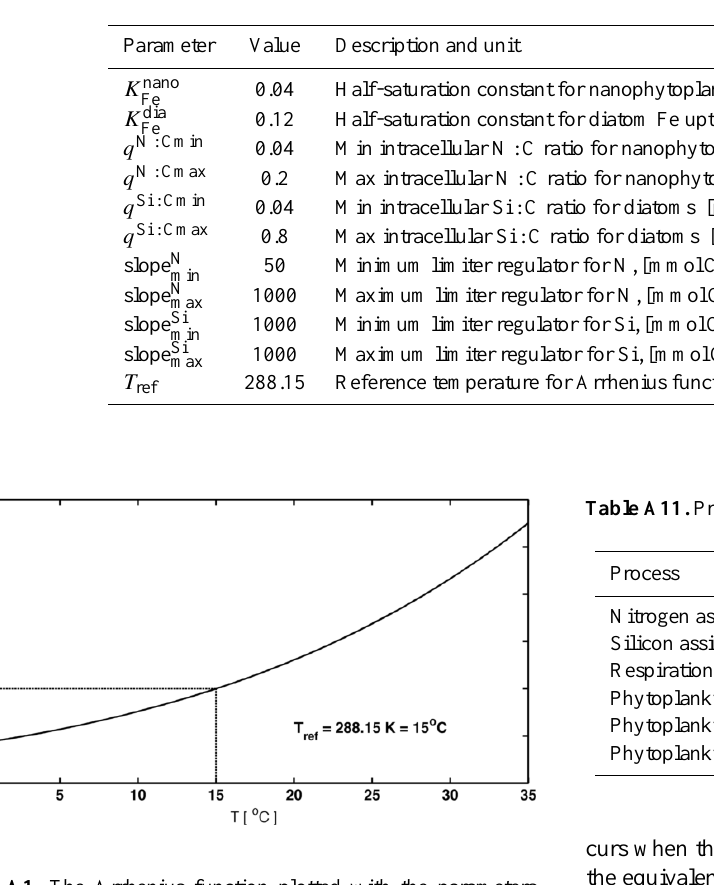
Figure A1. The Arrhenius function plotted with the parameters used in REcoM2.